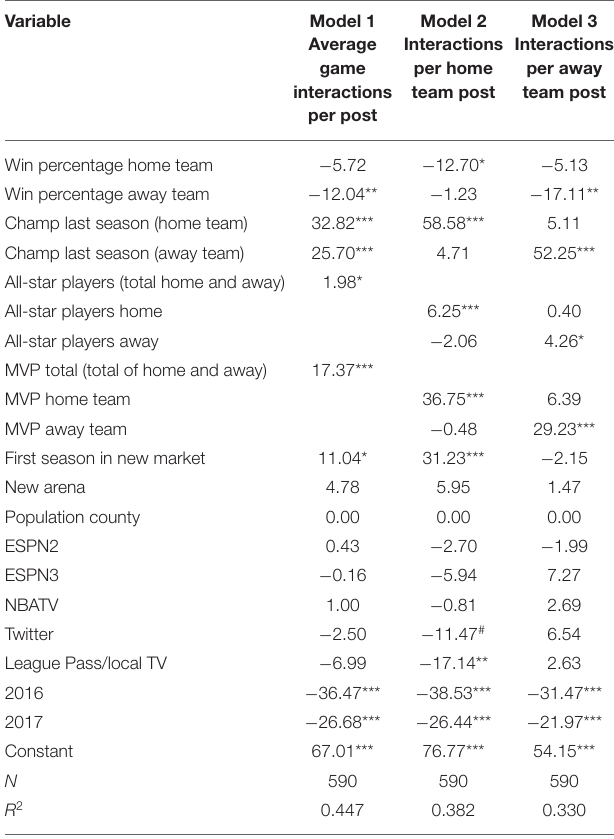
TABLE 2 | Effect of broadcast type and team quality on interactions per Twitter